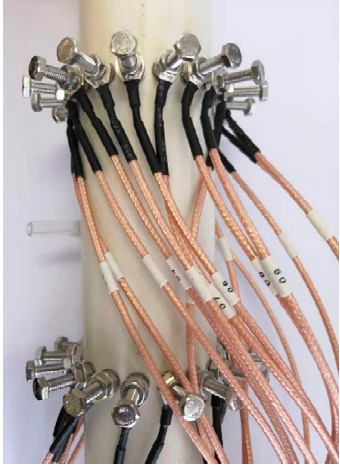
Figure 5. Photograph of the ERT sensor.